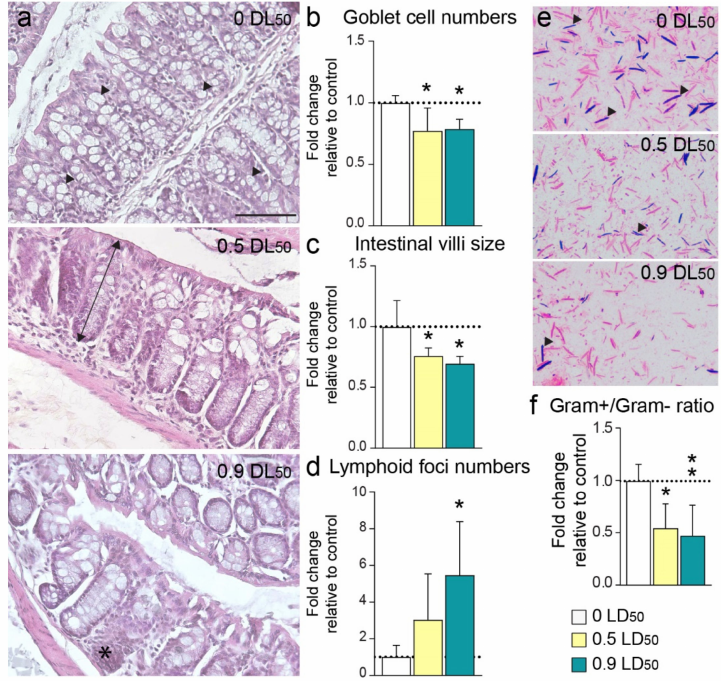
Figure 7. Long-term morphological changes in the large intestine induced by NIMP exposure. ( a ) Large intestine pictures of CTL (top panel), 0.5 LD50 (middle panel) and 0.9 LD50 (bottom panel) mice. Scale bar = 100 µ m. Mucin-producing goblet cells (arrow heads) were identified in colon sections of CTL mice. The double arrow indicates an example of villus size in a 0.5 LD50 NIMP- exposed mouse; the asterisk indicates a lymphoid focus in a 0.9 LD50 NIMP-exposed mouse. Fold change in ( b ) goblet cell numbers (1.0 ± 0.03 for 0 LD50; 0.77 ± 0.08 for 0.5 LD50 and 0.79 ± 0.03 for 0.9 LD50), ( c ) villi size (1.0 ± 0.10 for 0 LD50; 0.76 ± 0.03 for 0.5 LD50 and 0.70 ± 0.03 for 0.9 LD50) and ( d ) lymphoid foci numbers (1.0 ± 0.28 for 0 LD50; 3.02 ± 1.12 for 0.5 LD50 and 5.46 ± 1.31 for 0.9 LD50) normalized to CTL values at 6 months post-intoxication. Significant differences were determined by one-way ANOVA (F = 5.5, p = 0.02 for goblet cell numbers; F = 6.87, p = 0.01 for villi size; F = 4.89, p = 0.028 for lymphoid foci numbers) with Tukey’s multiple comparisons test. (* p < 0.05 CTL vs. NIMP-treated mice). ( e ) Gram − stained stool smears in the large intestine of CTL (top panel), 0.5 LD50 (middle panel) and 0.9 LD50 (bottom panel) mice. Arrow heads illustrate Gram+ bacteria stained blue, while Gram − bacteria are stained pink (X100). ( f ) The ratio of Gram+/Gram − bacteria normalized to CTL animals (1.0 ± 0.7 for 0 LD50; 0.55 ± 0.09 for 0.5 LD50 and 0.47 ± 0.11 for 0.9 LD50). Significant differences were determined by one-way ANOVA (F = 7.6, p = 0.0047) with Tukey’s multiple comparisons test. (** p < 0.01; * p < 0.05 CTL vs. NIMP-treated